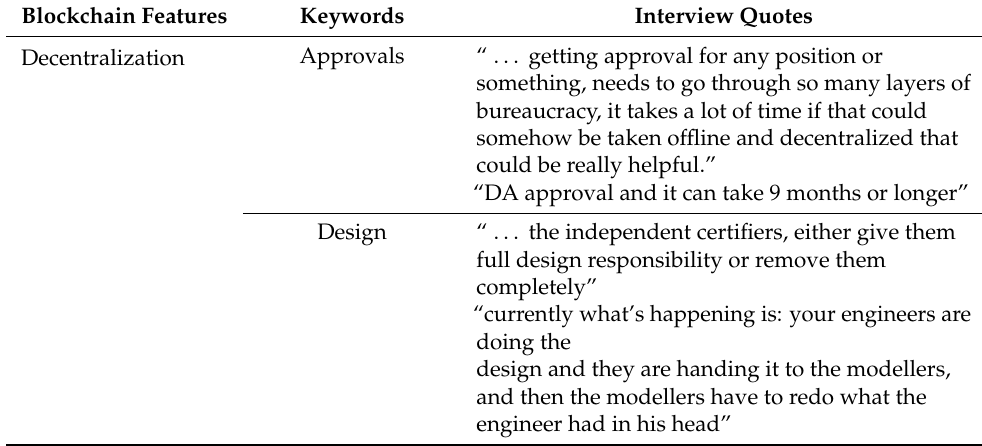
Table 10. Interview quotes in relation to the decentralized collaboration, data sharing, and automation